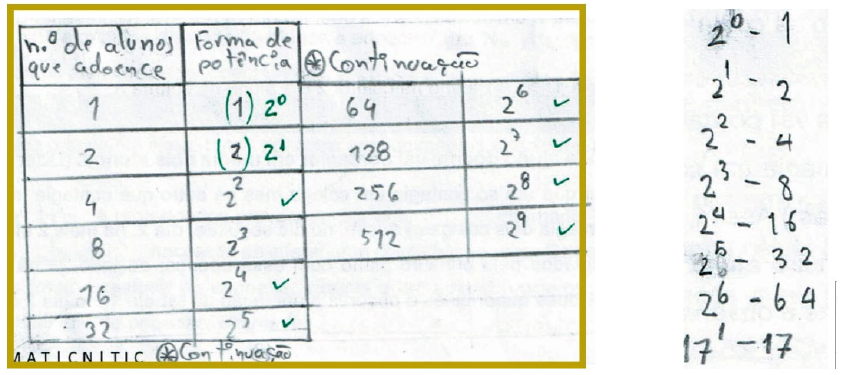
Figure 3. Writing the numbers in column two in powers of two.